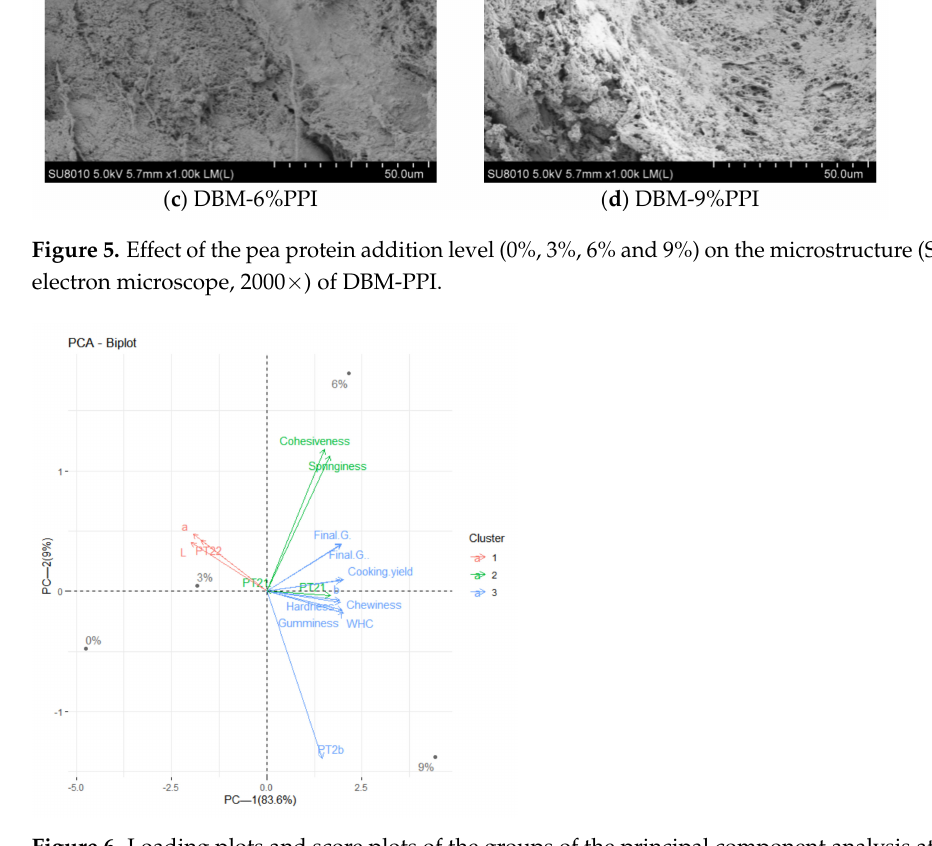
Figure 6. Loading plots and score plots of the groups of the principal component analysis at various levels of the addition of PPI (0%, 3%, 6% and